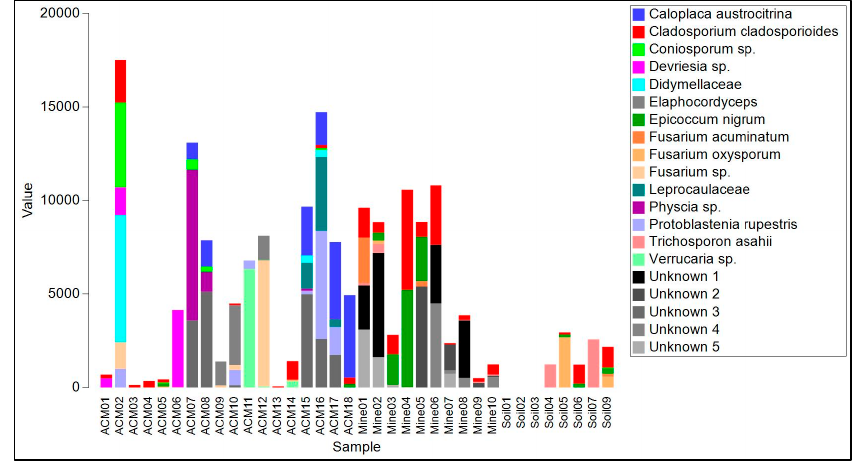
Figure 4. Read frequency of the 20 most abundant amplicon sequence variants (ASVs) from the ITS region found in each sample.